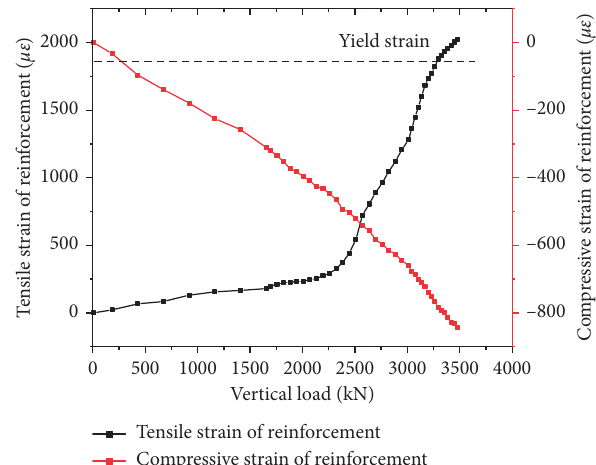
Figure 11: Strain of the main reinforcement at the vault position of the target segment of the middle